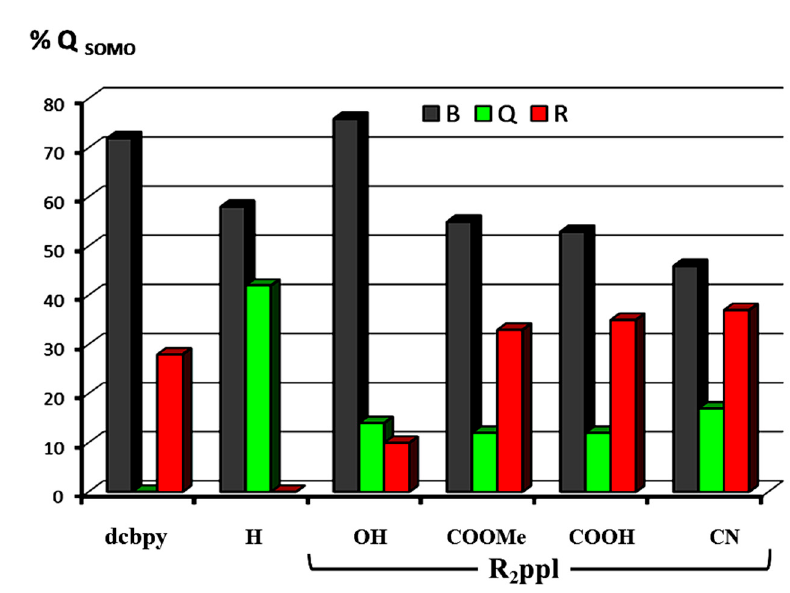
Figure 17. Charge distribution on B, Q, R fragments in the SOMO orbital.